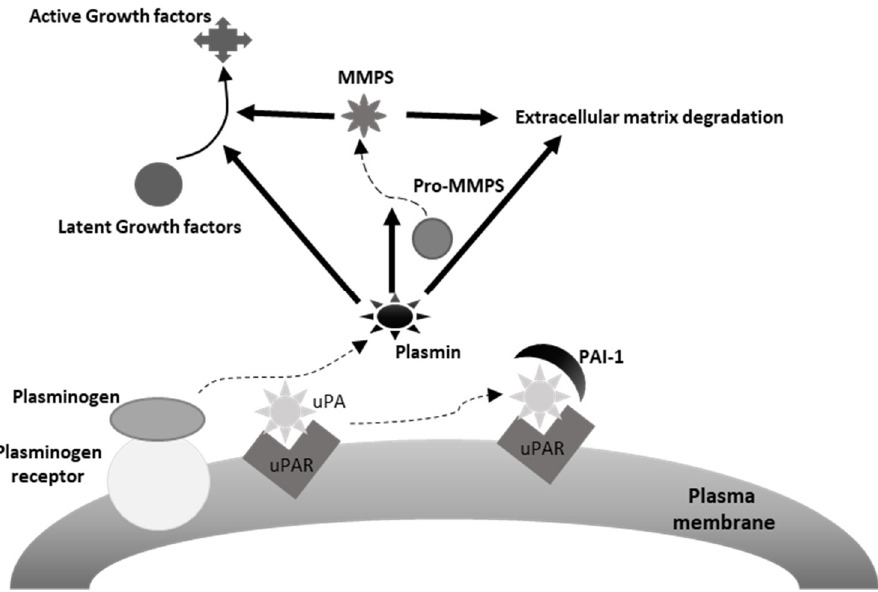
Figure 2. Depiction of the urokinase plasminogen activating system. uPA, urokinase plasminogen activator, uPAR, uPA receptor, PAI-1, plasminogen activator inhibitor-1. As it may be appreciated in the figure, plasmin induces extracellular matrix degradation directly and indirectly, through the activation of extracellular matrix bound MMPs (matrix metalloproteinases). Similarly, plasmin may activate latent mitogenic and motogenic growth factors associated with the extracellular matrix, thus promoting tumor cell proliferation and invasion.